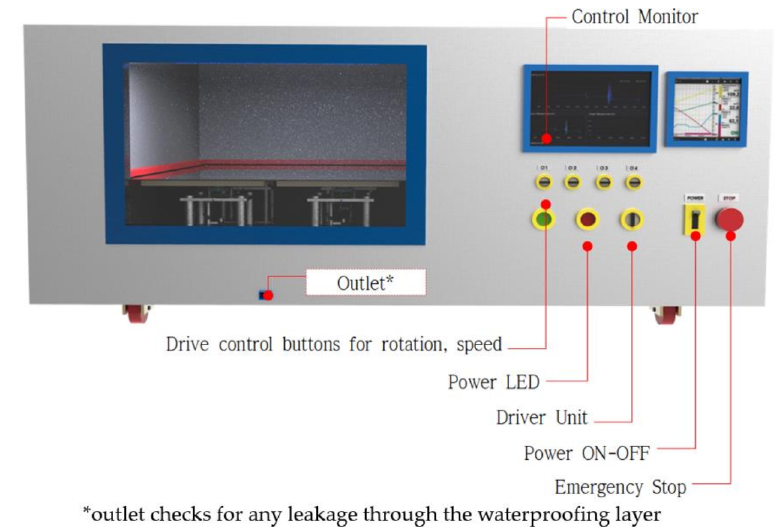
Figure 7. Experimental equipment design illustrated.